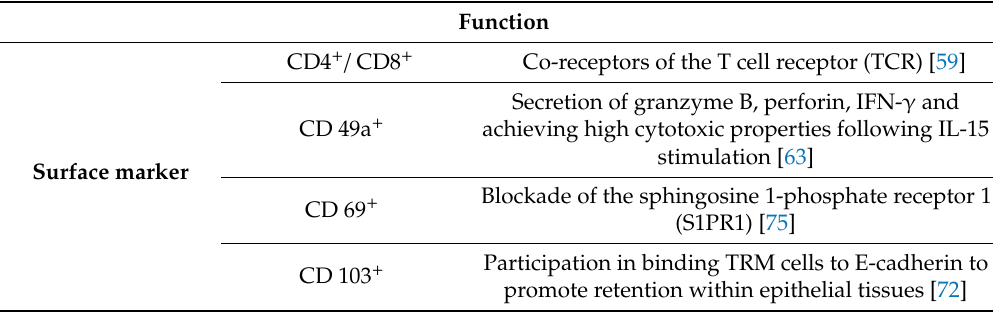
Table 2. Surface markers of T RM cells and their main